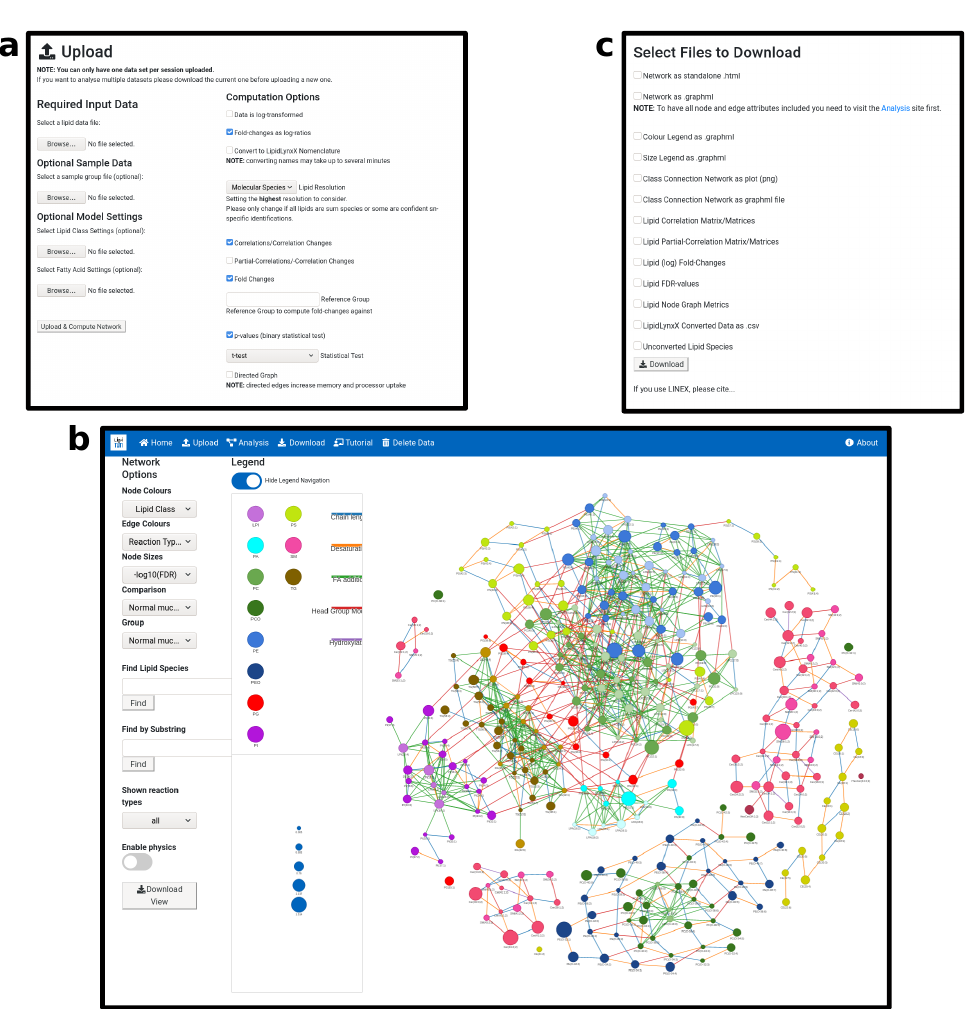
Figure A2. Main interfaces of the LINEX web-app. ( a ) Upload of lipidomics data with optional group labels for samples. Statistical methods can be selected for the visualization on the resulting network. Additionally, information about metabolic reactions and lipid classes can be uploaded to extend the network. ( b ) Analysis page. Here, the lipid networks can be interactively investigated and statistical or biochemical properties can be shown. ( c ) Download page. The network can be downloaded including all computed statistical